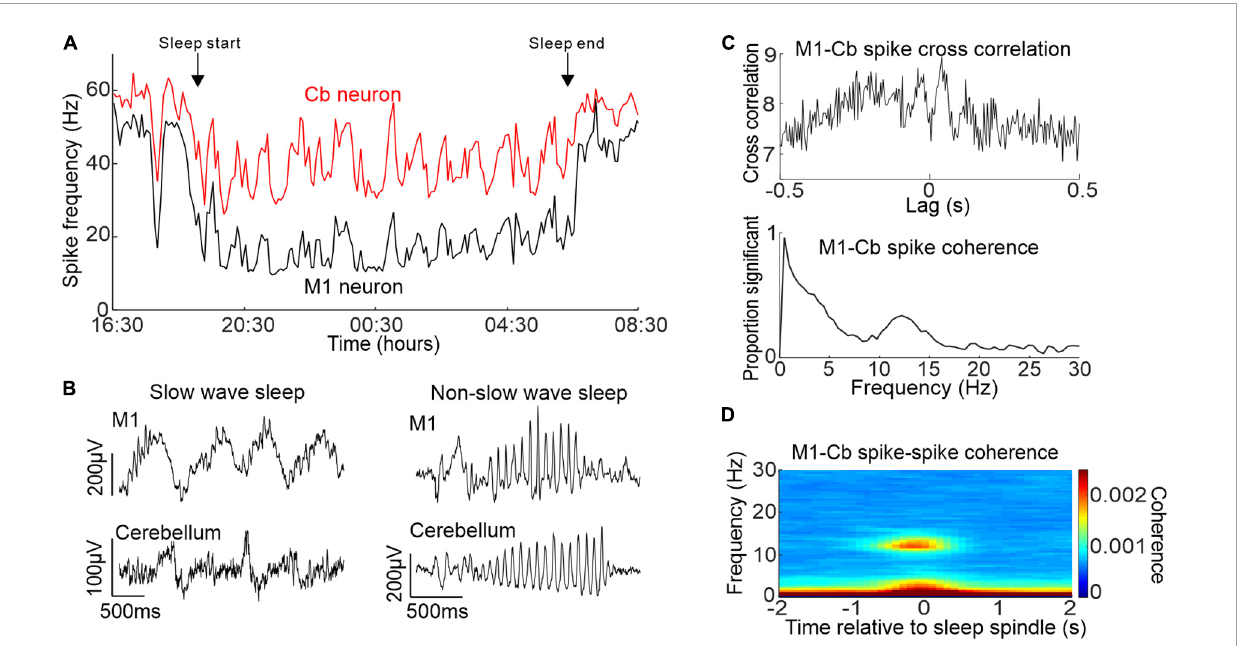
FIGURE2 Activity of M1 and cerebellum during sleep. (A) Simultaneously recorded M1 and cerebellar neuronal spiking rate over an entire sleep period. (B) Example simultaneous M1 and cerebellar slow oscillations (left) and sleep spindles (right). (C) Top: example cross-correlation between an M1 and cerebellar spike train during sleep showing both low frequency and spindle frequency components. Bottom: proportion of significant spike-to-spike coherence between pairs of M1 and cerebellar neurons in sleep. (D) M1-cerebellar spike coherence aligned by neocortical sleep spindles. Figures adapted with permission from Xu et al. (2021).